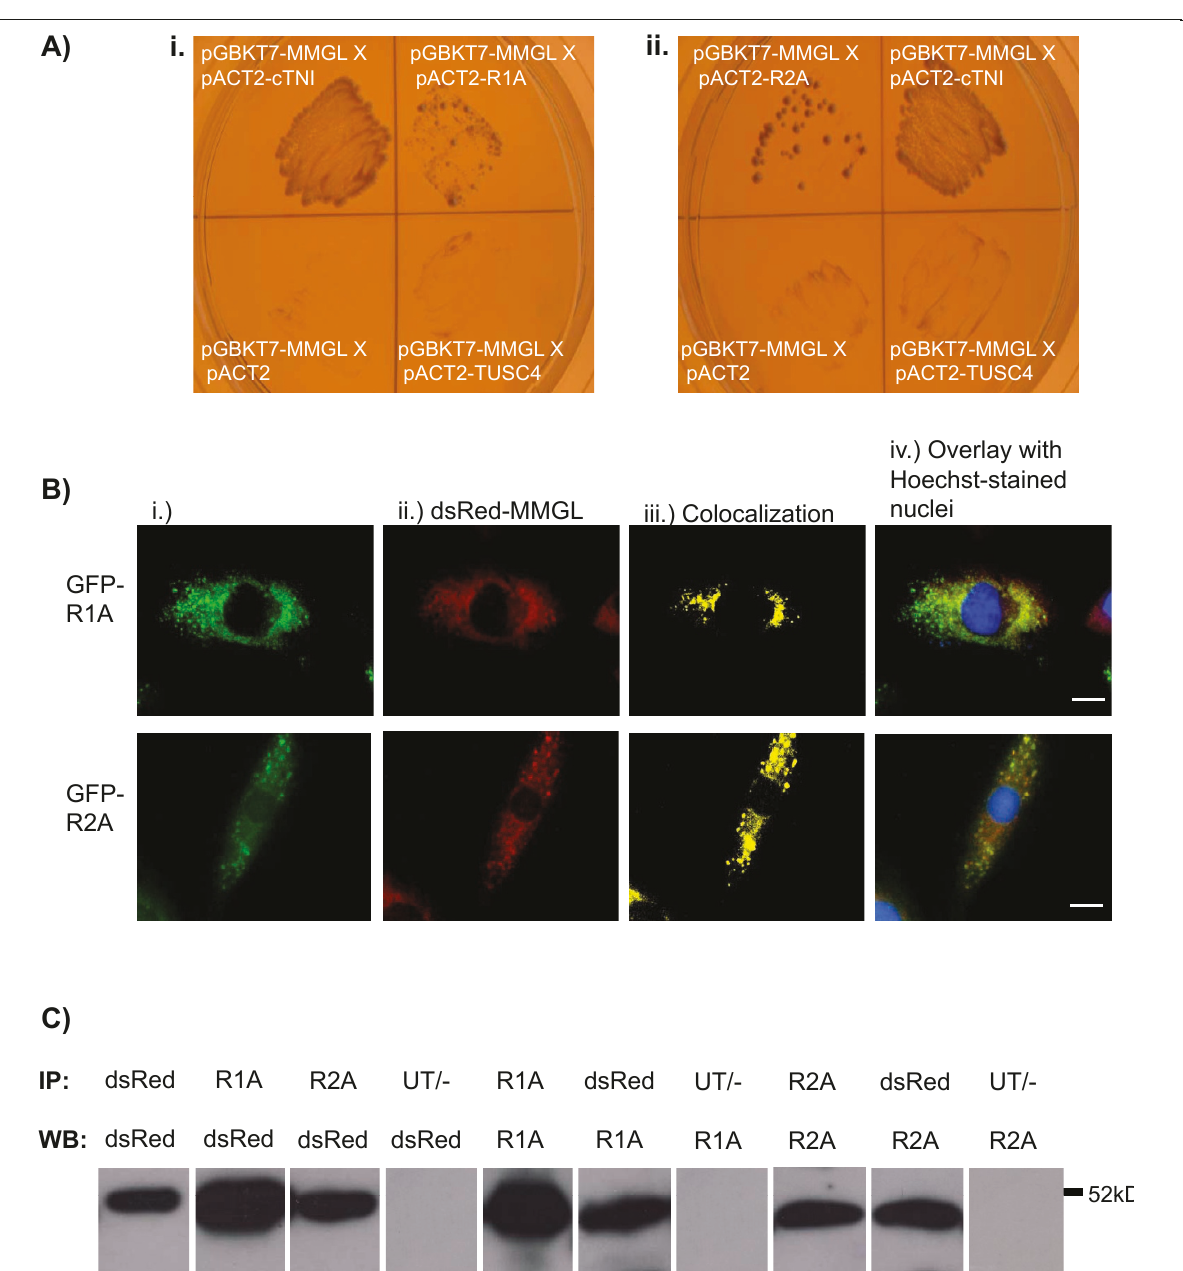
Figure 3 MMGL acts as a dual-specific AKAP by anchoring PKA regulatory isoforms R1A and R2A . A . Activation of nutritional reporter genes by PKA-MMGL interaction during direct protein-protein interaction assays. Small-scale Y2H matings between pGBKT7-MMGL and pACT2- PRKAR1A (i) and pACT2-PRKAR2A (ii) on solid medium lacking Leu, Trp, His and Ade. Growth of yeast yells indicate interaction of MMGL with PRKAR1A as well as PRKAR2A. B . Representative images of live cell fluorescence microscopy showing co-localization of MMGL with PRKAR1A and PRKAR2A in differentiated H9C2 cardiomyocytes. (i) GFP-tagged PRKAR1A and PRKAR2A is seen in the cytosol as green fluorescence. (ii) dsRed- tagged MMGL expression is seen as red fluorescence. (iii) Yellow fluorescence indicates the co-localization of PRKAR1A and PRKAR2A with MMGL. (iv) Overlay of images A-C with Hoechst H-33342 labelling of the nuclei (blue fluorescence), for orientation purposes. Scale bar: 0.02 mm. C . Western blots of in vivo co-immunoprecipitations of PKA regulatory subunits and MMGL; the antibodies used in immunoprecipitation (IP)